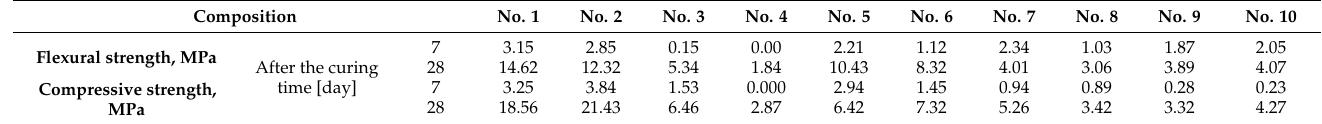
Table 4. Mechanical compressive and bending strength of the hardened saline cement